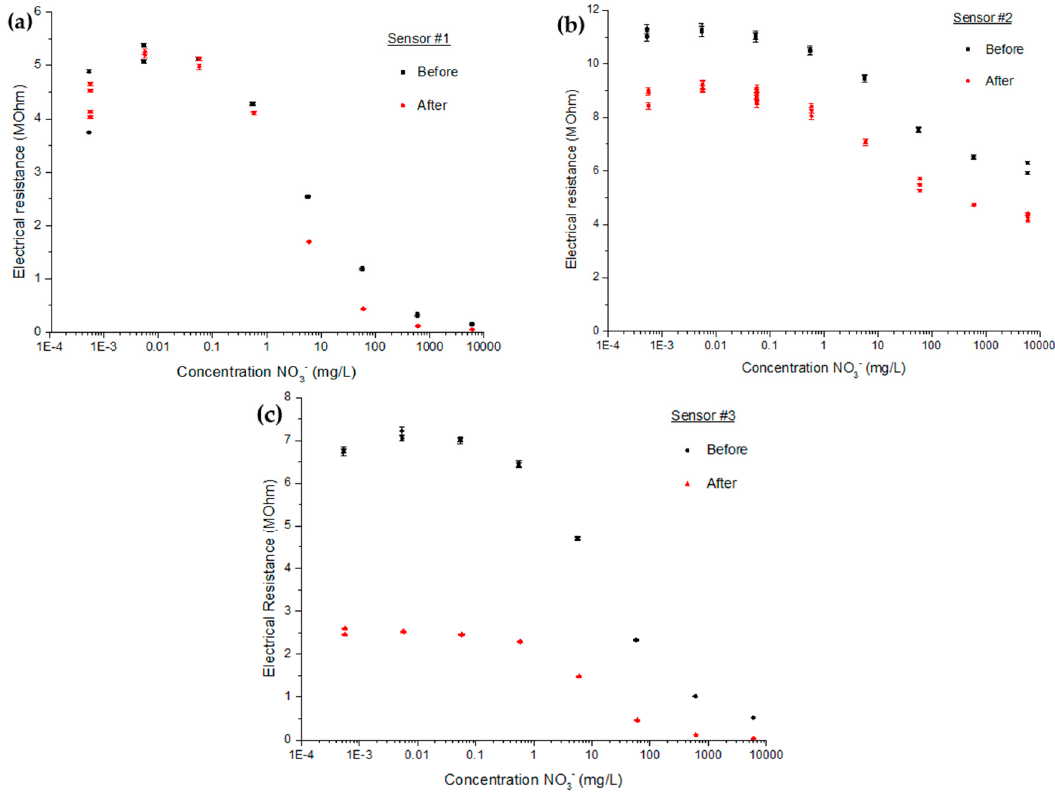
Figure 7. Calibration curves obtained by pure KNO 3 solutions before and after a month of exposition to medium under forest nursery environmental conditions. The sensors are addressed as ( a ) sensor #1; ( b ) sensor #2; and ( c ) sensor #3.